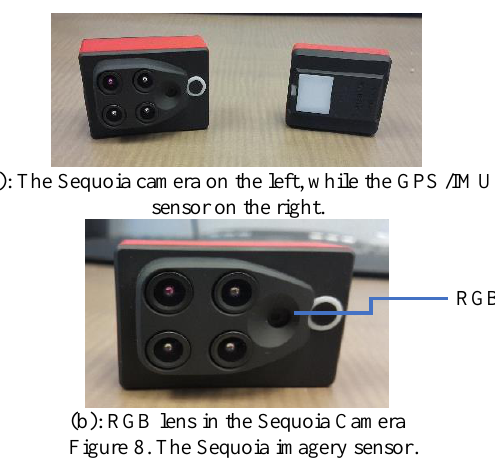
Figure 8. The Sequoia imagery sensor.